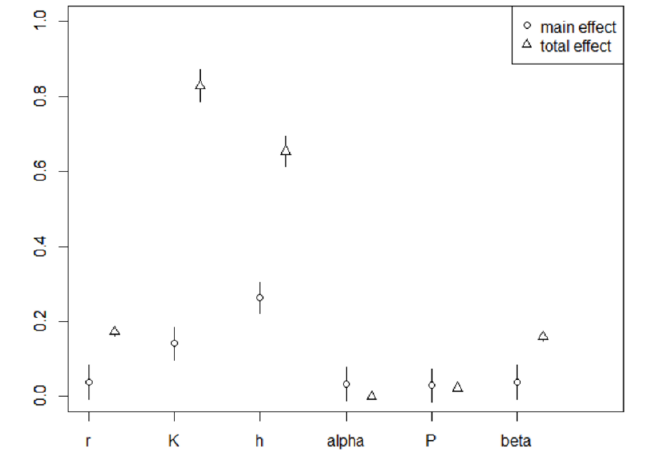
Figure 5. Main and total Sobol–Martinez sensitivity indices for the GWI model.